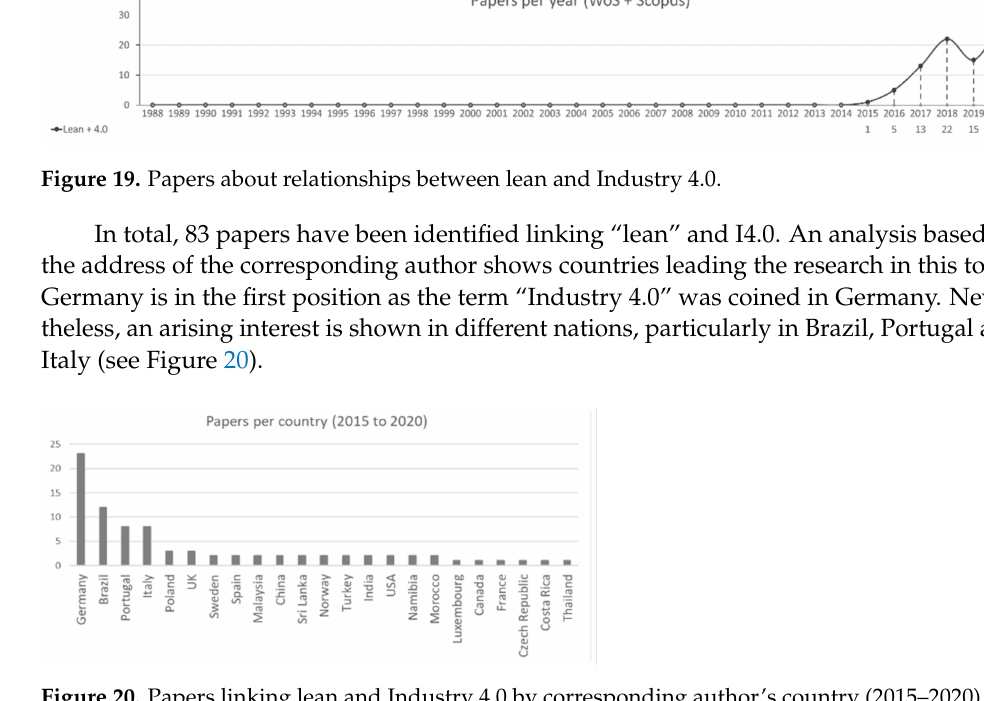
Figure 20. Papers linking lean and Industry 4.0 by corresponding author’s country